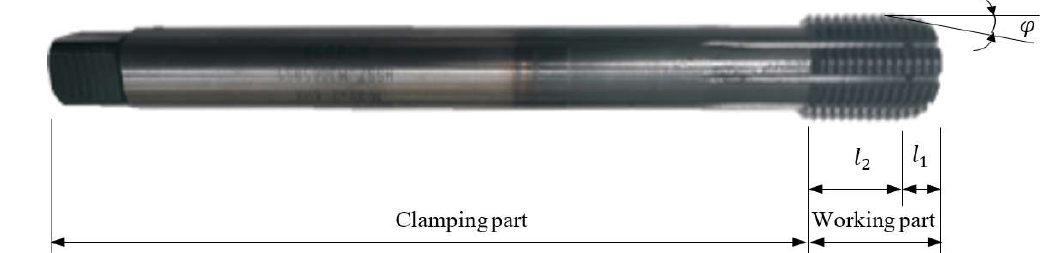
Figure 2. Structure of extrusion